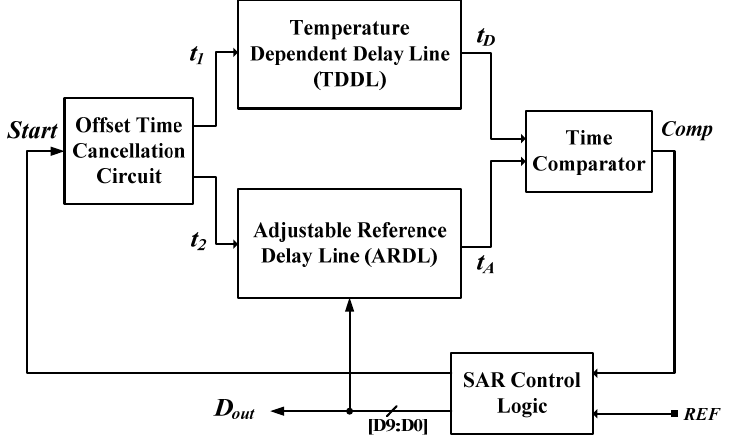
Figure 2. Block diagram of former smart temperature sensor with curvature compensation